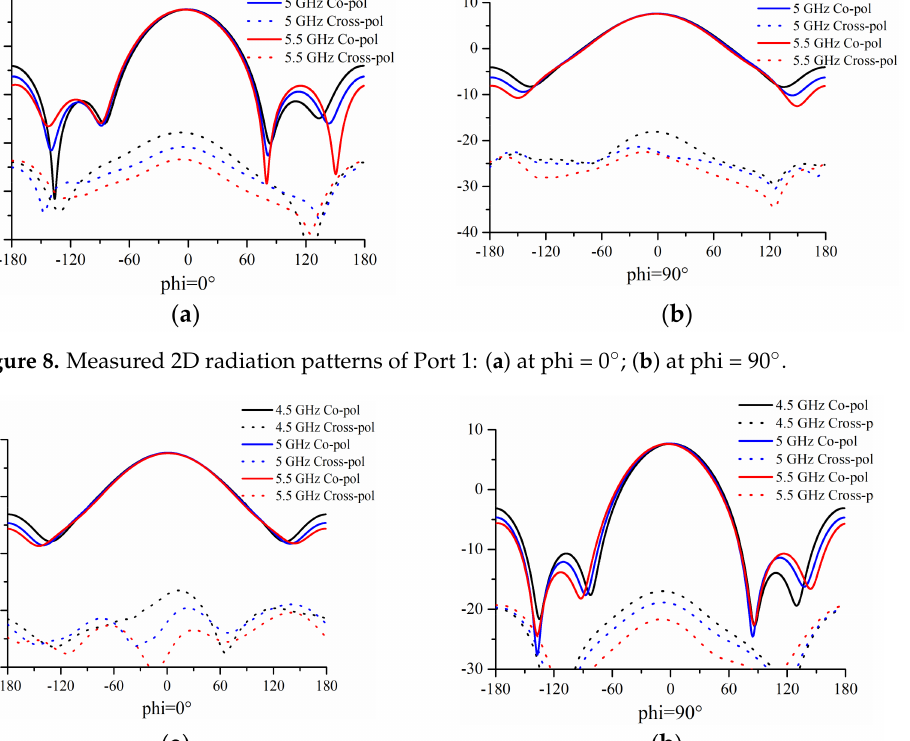
Figure 9. Measured 2D radiation patterns of Port 2: ( a ) at phi = 0 ◦ ; ( b ) at phi = 90 ◦